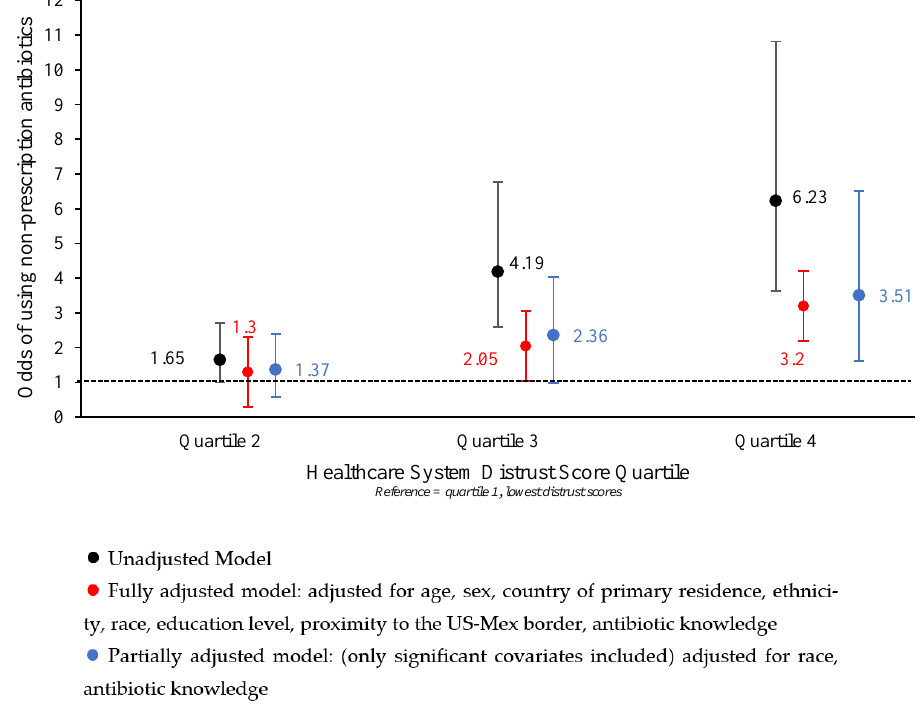
Figure 2. Odds of using non-prescription antibiotics by healthcare system distrust score quartile (n = 568).